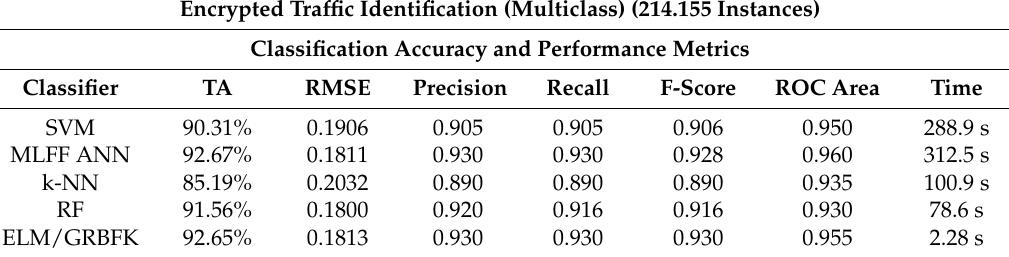
Table 5. Comparison between algorithms.